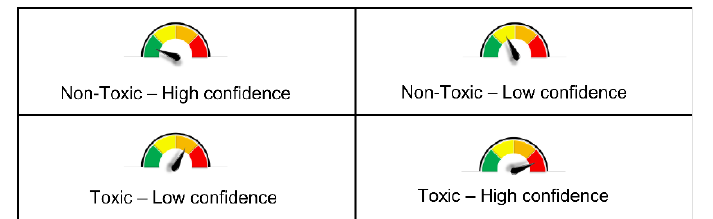
Figure 5. The graphical representation provided by VenomPred related to the confidence level of each prediction, derived from the Probability